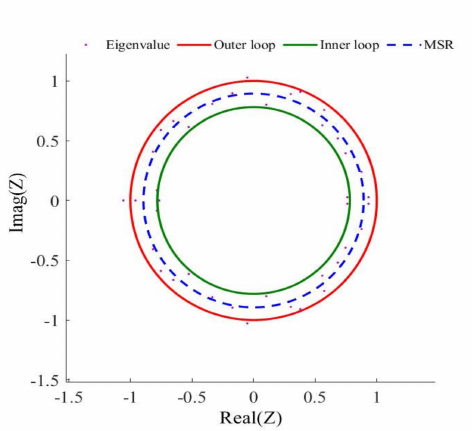
Figure 1. The inner and outer loop distributed figure of the monocyclic